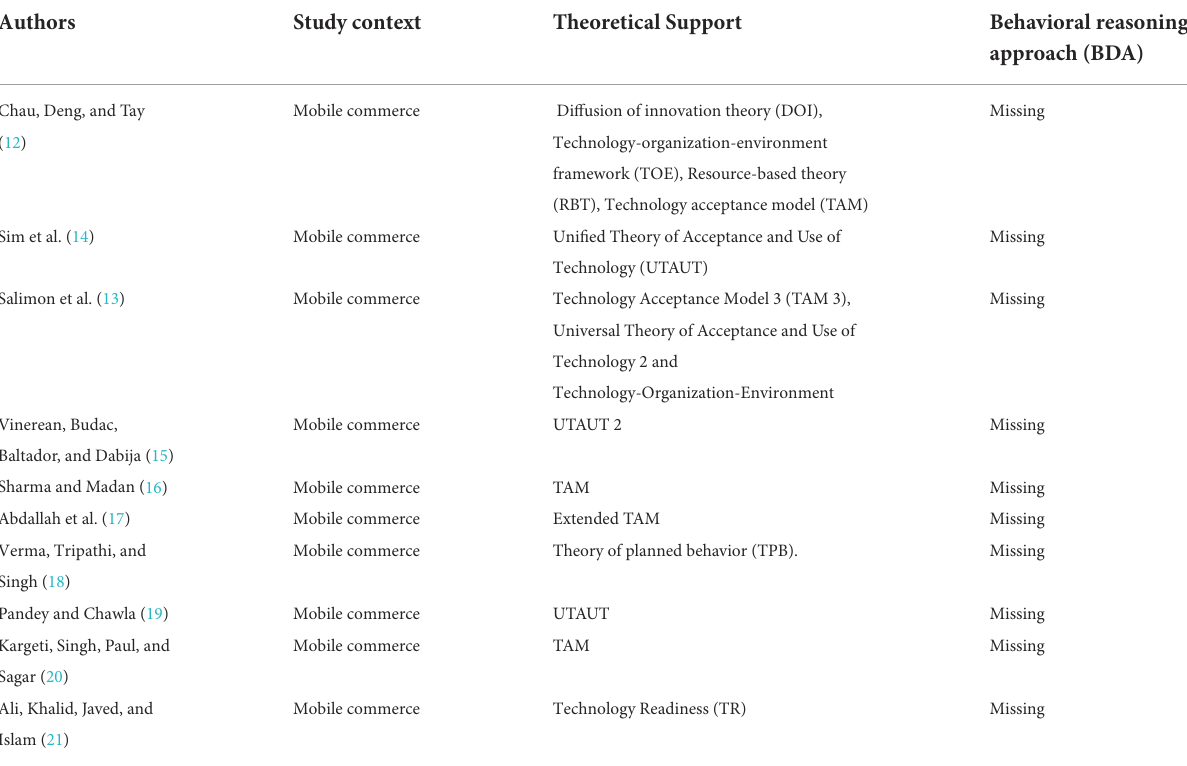
TABLE 1 Summary of prominent studies on